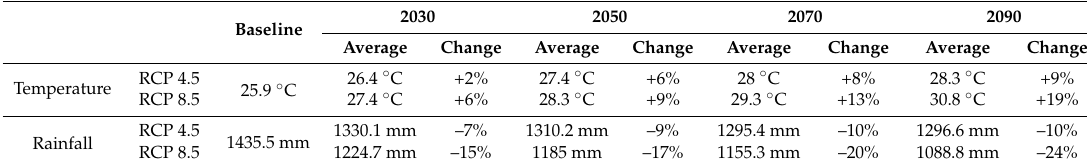
Table 2. Projected changes of temperature and rainfall for the 21st century in the Sassandra River Basin under RCPs 4.5 and 8.5.